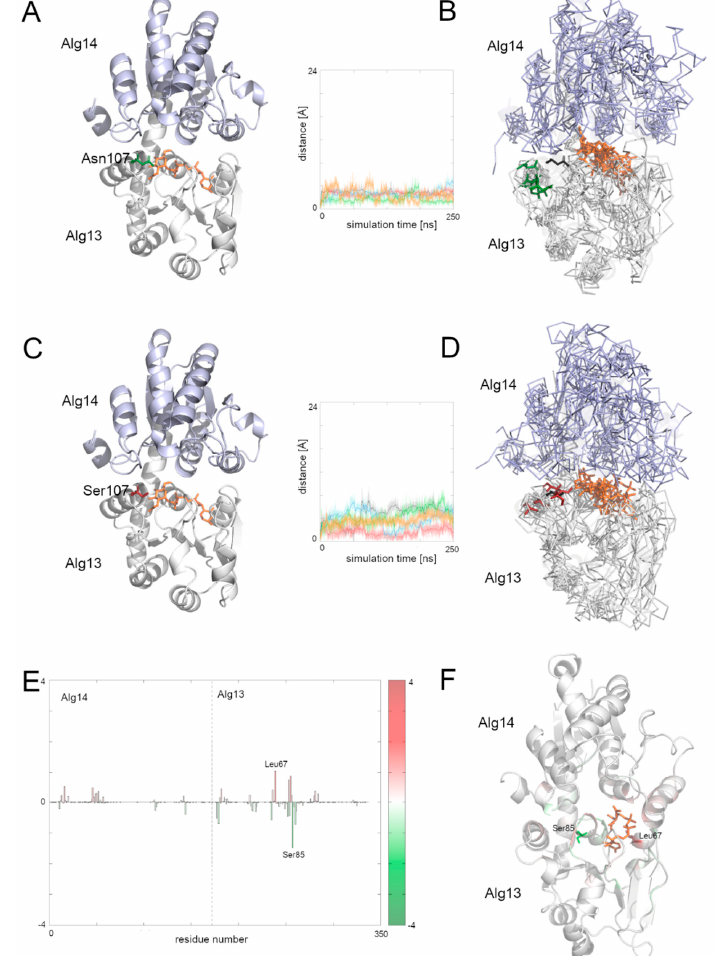
Figure 6. Different interactions with the UDP-GlcNAc substrate of the human Alg13-Alg14 dimer with native Alg13 protein and its Asn107Ser variant. ( A ) Native Alg13-Alg14 dimer structure with substrate, ( B ) a set of five structures at the end of the simulation of the native human Alg13-Alg14 with substrate, ( C ) Alg13-Alg14 dimer with Alg13 Asn107Ser variant with substrate, ( D ) a set of five structures at the end of the simulation of the Alg13-Alg14 dimer with the Alg13 Asn107Ser variant with substrate, ( E ) differences in per-residue free energy contribution in substrate binding plot, ( F ) structure in the last frame of the simulation of the Alg13-Alg14 dimer with the Asn107Ser variant colored according to the differences in per-residue free energy contribution to substrate binding. The starting point structure is shown as cartoons with the 107 residue and the substrate shown as sticks. The Alg14 protein is colored light blue. The protein structure is rotated about 180 ◦ with respect to the position of Alg13 in Figure 3. The native Alg13 Asn107 is colored green, and the Asn107Ser residue is red. The substrate is shown as orange sticks. The set of five structures at the end of the simulation are shown as ribbons, and the starting point structure (transparent cartoons and black sticks for the starting position of the 107 residue) overlaps with them. Distance plots show the distance between the starting position of Alg13 107 residue’s C α atom and its position in each simulation frame; each colored line represents one simulation. The values of the difference in per-residue free energy contribution in the substrate binding were calculated in a way that the energy values of the mutant variant were subtracted from the values of the native protein. Residues with the highest differences in per-residue contribution (higher than +1 kcal/mol and lower than − 1 kcal/mol) are shown on panels ( E , F